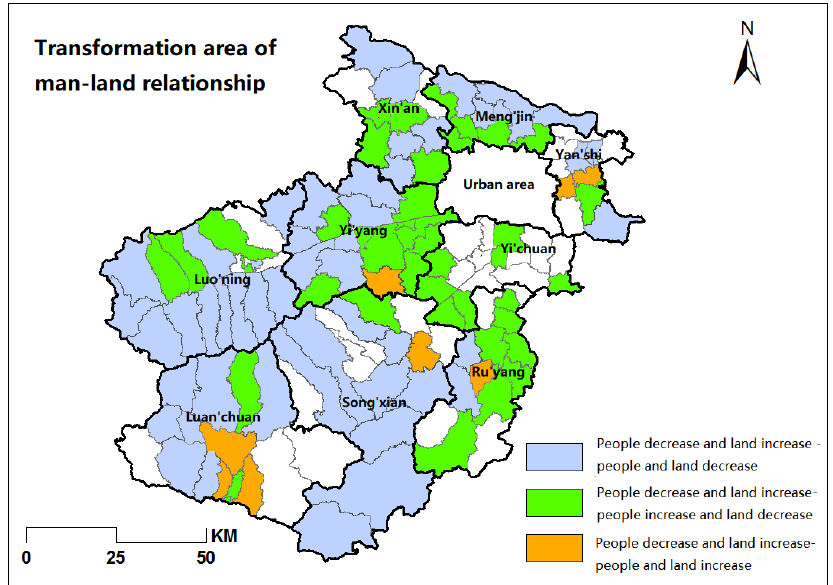
Figure 8. Distribution of human-land relationship coupling type